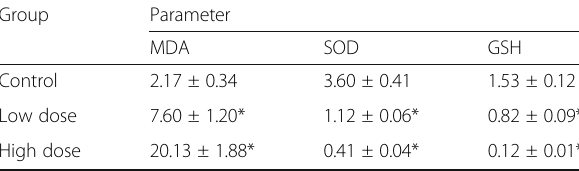
Table 2 The effect of BPA on testis MDA, SOD, and GSH level Group